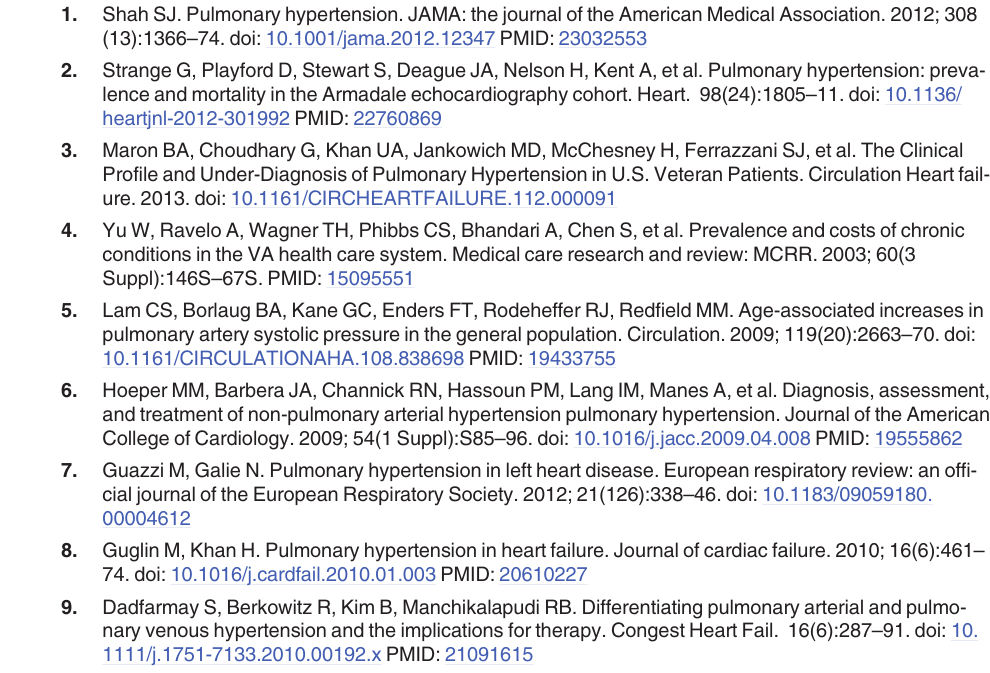
S1 Fig. Representative images showing M-Mode of the tricuspid annulus on the same pa- tient derived using Image J (A) or acquired at time of study